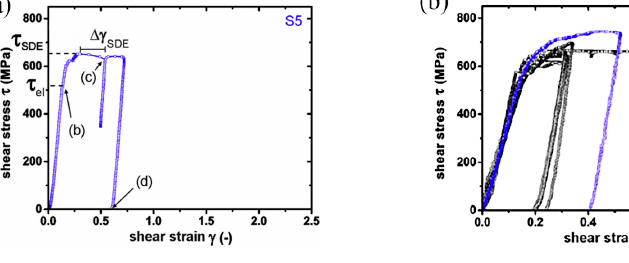
Figure 9. The mechanical results of a specimen ( a ) under (111)[011] shear loading (single slip orientation); ( b ) (111)[211] shear loading (double slip orientation); ( c ) (100)[010] shear loading (multiple slip orientation) [89].